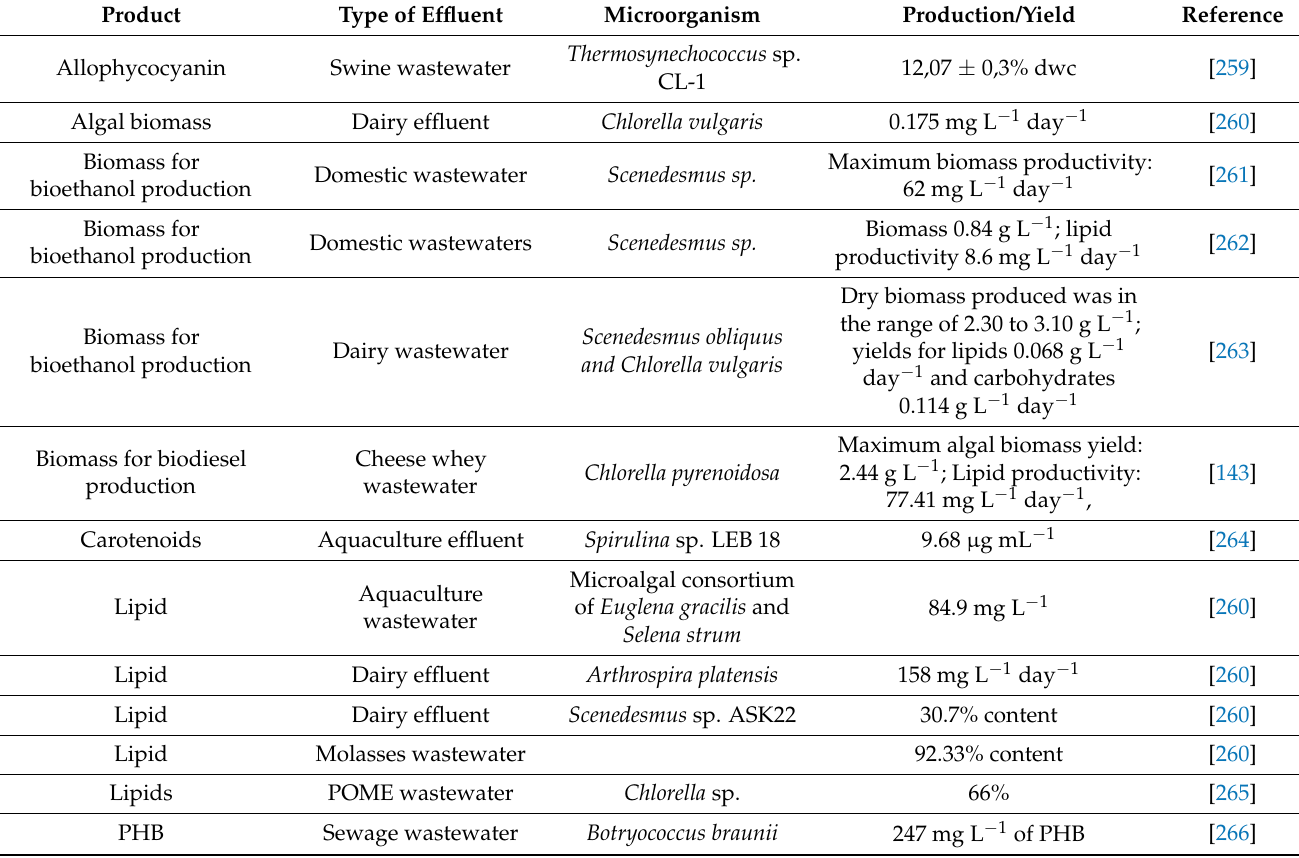
Table 6. Microalgal products from different